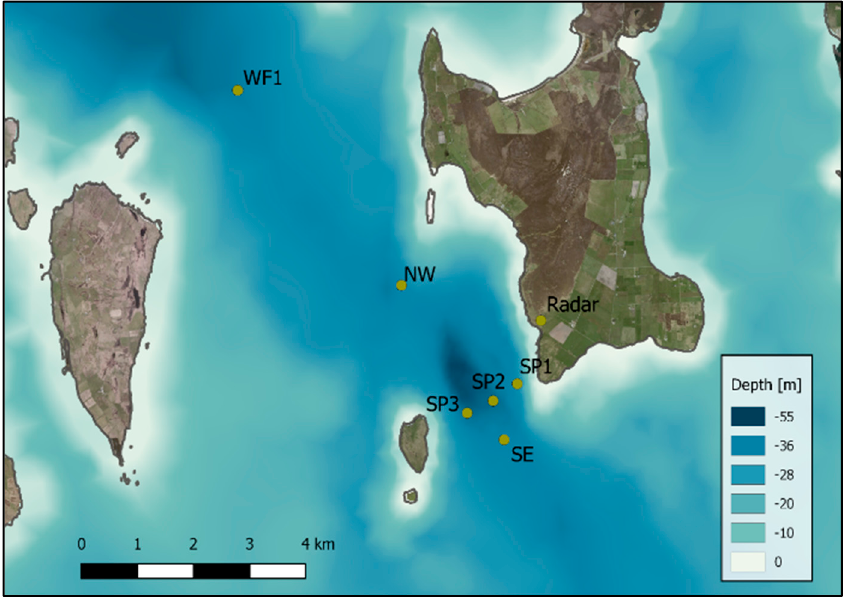
Figure 1. Sensor deployment locations for the Fall of Warness measurement campaign with the bathymetry provided by UK Hydrographic Office. Table 1. Sensor